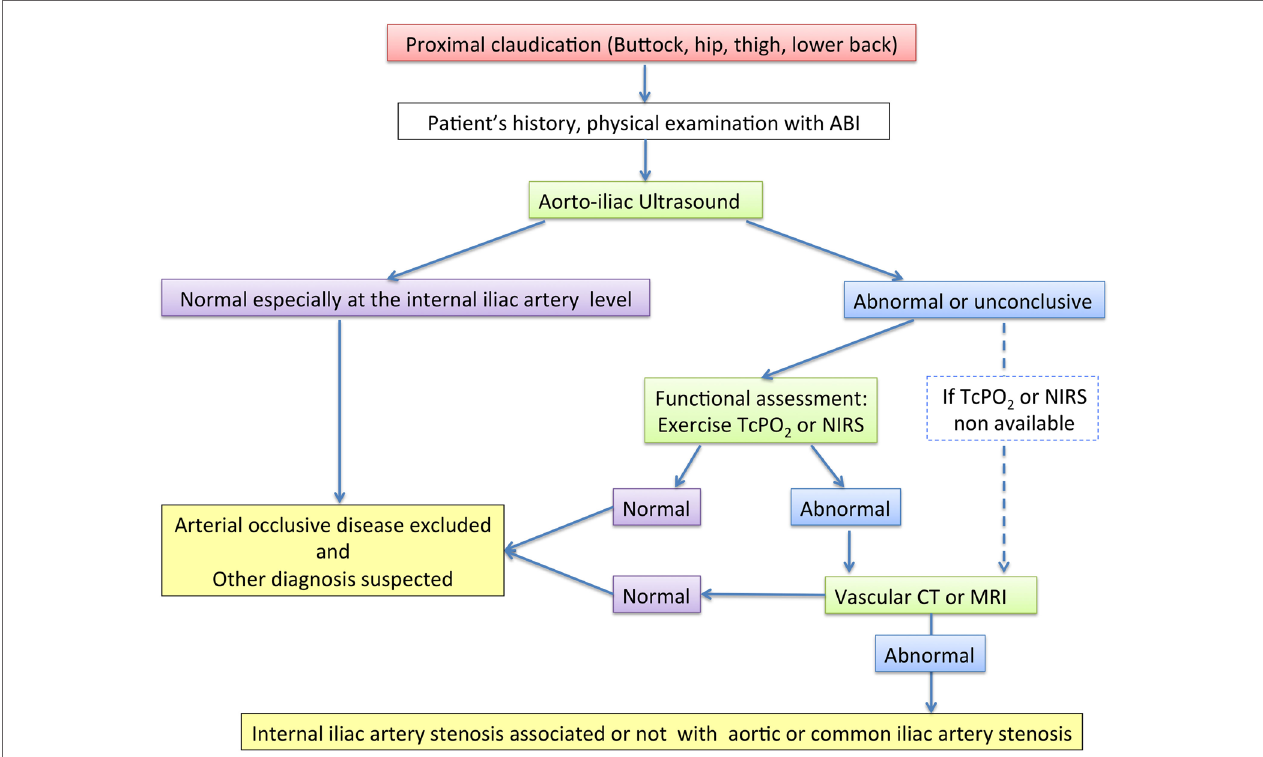
FiGURe 4 | Diagnosis algorithm . ABI, ankle-brachial index; Exercise-TcPO 2 , exercise transcutaneous oxygen pressure measurement; Exercise-NIRS, near-infrared spectroscopy; CT, computed